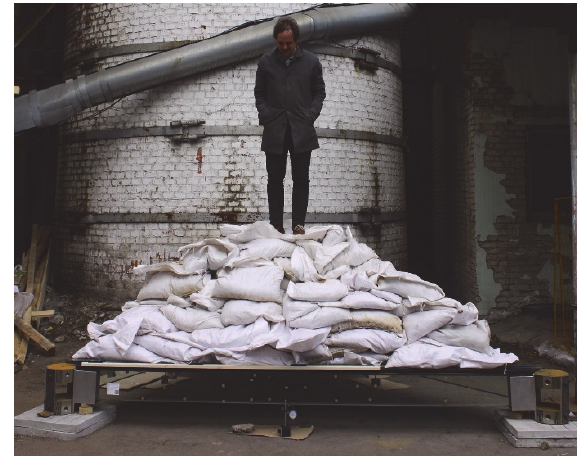
Fig. 12: Full Scale Testing of Glass Beam, Nodes and Panels